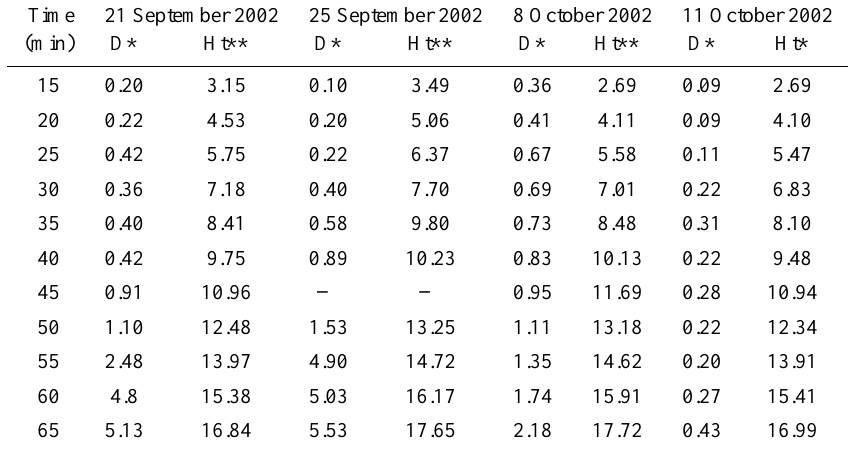
Table 2. Location of the balloon as a function of height for four different days (21 September, 25 September, 8 October and 11 October 2002). Time